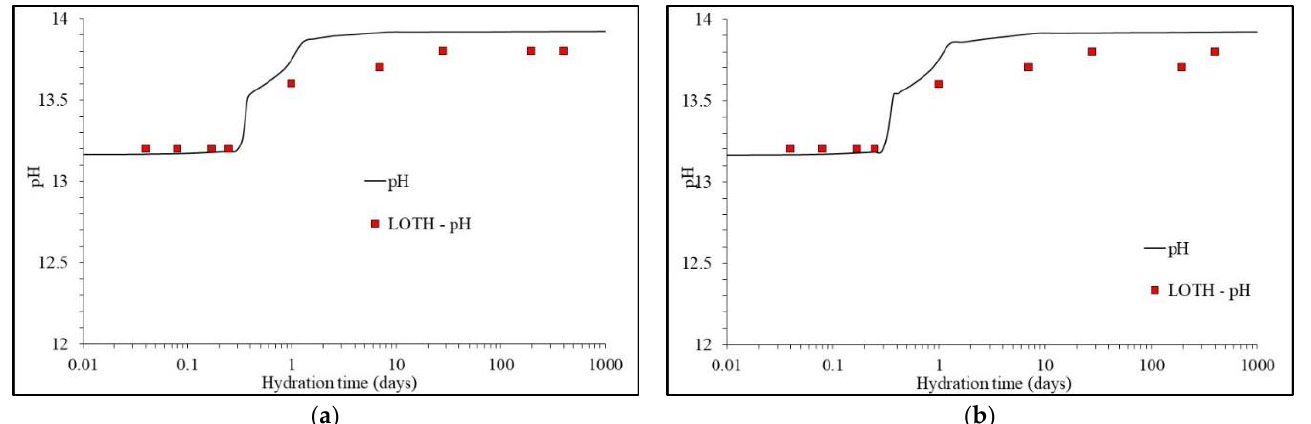
Figure 4. pH predictions for ( a ) OPC and ( b ) 4% limestone binder (LOTH represents the measured data from [20]). ( a ) OPC pH; ( b ) 4% limestone pH.